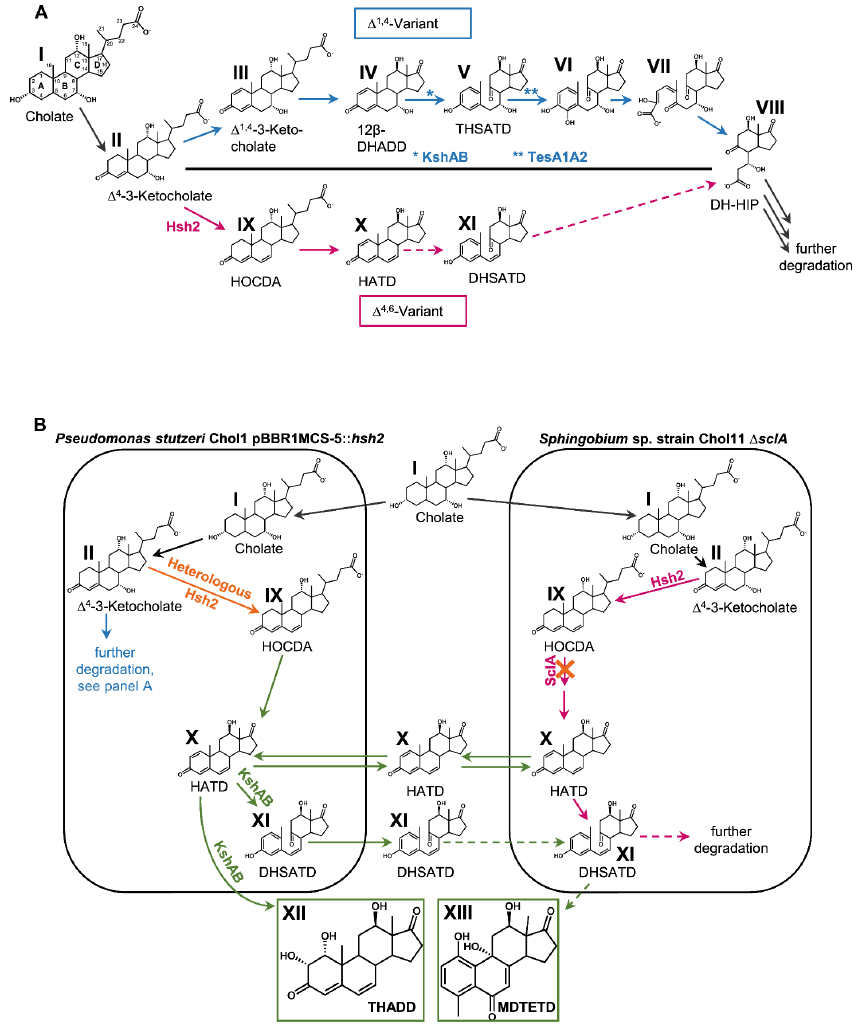
Figure 1. ( A ) Section of cholate degradation via the ∆ 1,4 - and ∆ 4,6 -variants of the 9,10- seco -pathway. For a detailed description and illustration of the pathway, including all known enzymes involved in bile salt degradation, see review [6]. ( B ) Principle of the co-culture designed for providing DHSATD (XI) to Sphingobium sp. strain Chol11 . The heterologous ex- pression of Hsh2 in P. stutzeri Chol1 leads to the accumulation of dead-end intermediates DHSATD (XI) and THADD (XII). The sclA deletion mutant strain Chol11 Δ sclA lacking the steroid C 5 -CoA ligase can use cholate only very slowly. Intermediates are produced inside the cells but can be found in the culture supernatant, most probably due to efflux. Black arrows: reaction present in both pathways, blue arrows: degradation via Δ 1,4 -pathway, red arrows: degradation via ∆ 4,6 -pathway, orange arrows: changes in metabolism compared to wild types, green arrows: cross-feeding reaction, solid lines: known reactions, dotted lines: reactions found in this study. I: Cholate, II: ∆ 4 -3-Ketocholate, III: ∆ 1,4 -3-Ketocholate, IV: 12 β -DHADD (7 α ,12 β